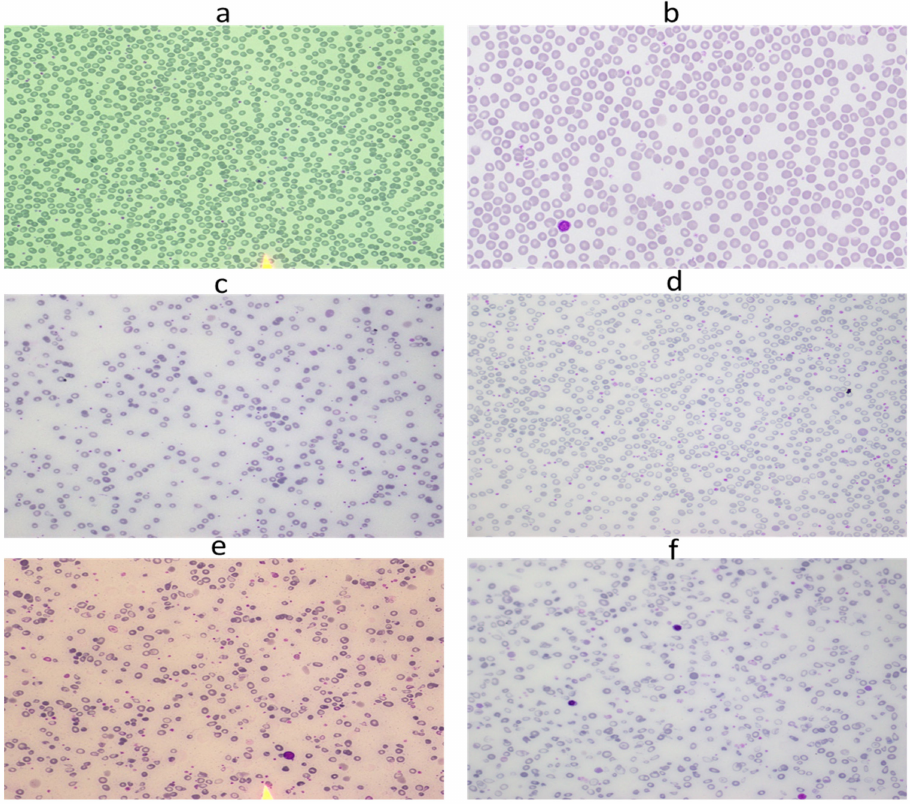
Figure 3. ( a , b ) Healthy RBCs image, ( c , d ) Mild stage RBC image ( e , f ) Chronic stage RBCs